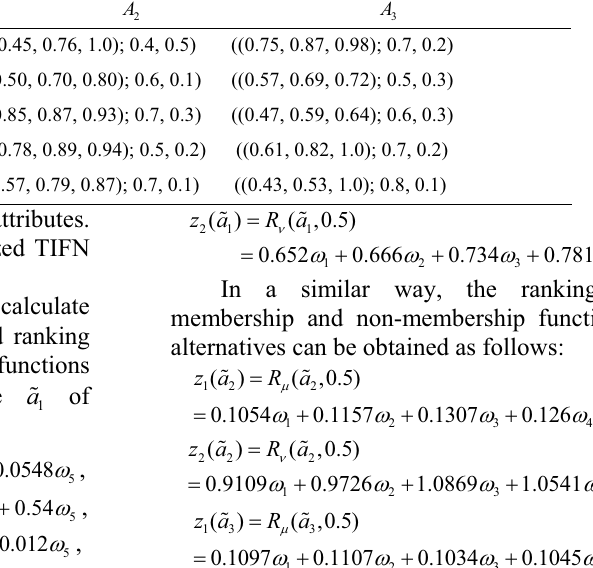
Table 6 The normalized TIFN decision matrix given by